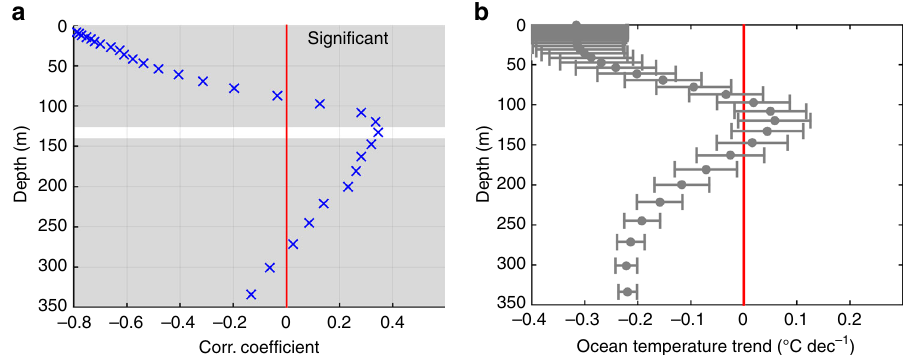
Fig. 5 Relationship between trends in ice concentration and ocean temperature at depth for the model driven by climatological winds. a Correlation between 1979 – 2013 trends in ice concentration and ocean temperature at depth for the model driven by climatological winds. Gray areas show the depths at which the correlations are signi fi cant at the 95% con fi dence level. b Mean depth-dependent ocean temperature trends (model-based, same simulation) over Ross Sea areas where ice concentration trends are positive and considered signi fi cant, i.e., larger than 3% dec − 1 , the typical interval of con fi dence for ice concentration trends. At each depth, the horizontal bar represents standard deviation around the spatially